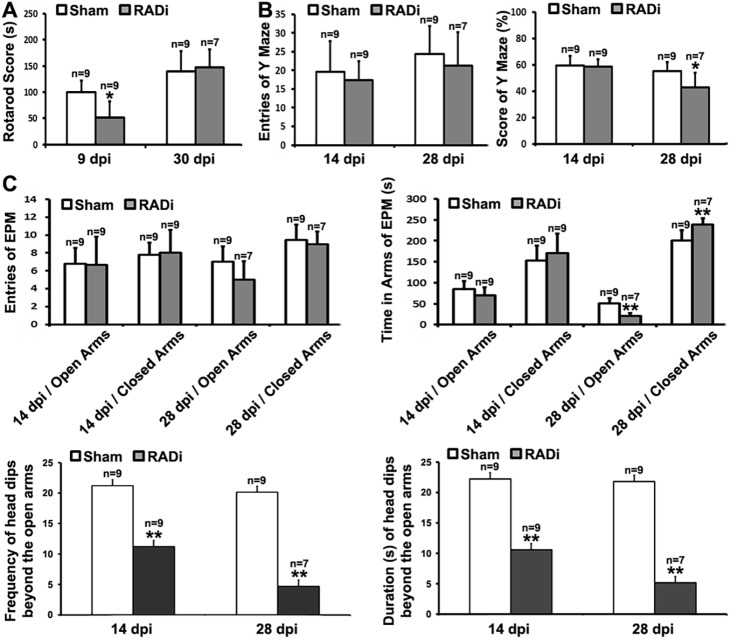
Neurobehavioral changes in sham and RADi mice. (A) Rotarod performance at 9 dpi and 30 dpi. Mice that experienced RADi showed much shorter duration on the rotarod than sham mice at 9 dpi but recovered at 30 dpi. (B) Y-maze test at 14 dpi and 28 dpi. Y-maze score but not number of arm entries significantly declined in RADi mice only at 28 dpi. (C) EPM at 14 dpi and 28 dpi. Mice that experienced RADi showed a robust increase in the time spent in the closed arms with a decreased interval spent in the open arms only at 28 dpi. However, a significant decrease in the frequency and total duration of head dips beyond the borders of the open arms was observed in mice with RADi at 14 dpi, which became progressively worse at 28 dpi. Data are presented as mean±s.d. and were analyzed by one-way with repeated-measures ANOVA followed by Tukey's post hoc test. *P<0.05, **P<0.01; n=9 for sham, n=9 for RADi at 9 dpi and 14 dpi, n=7 for RADi at 28 dpi and 30 dpi (two mice were lost for the late stages).